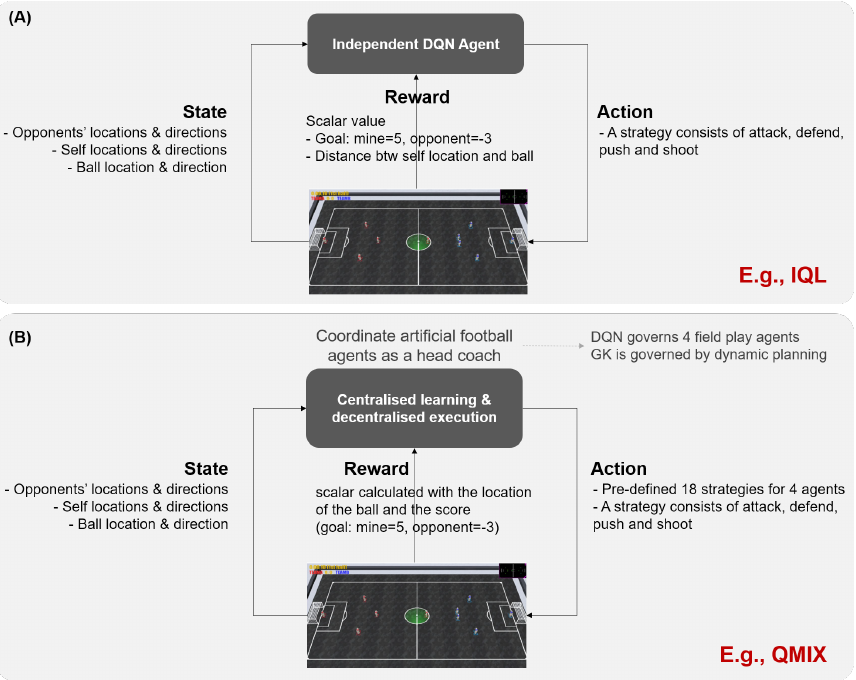
Figure 6. Two multi-agent RL techniques to build artificial football agents. ( A ) A framework for a single DQN agent in IQL. ( B ) A framework for